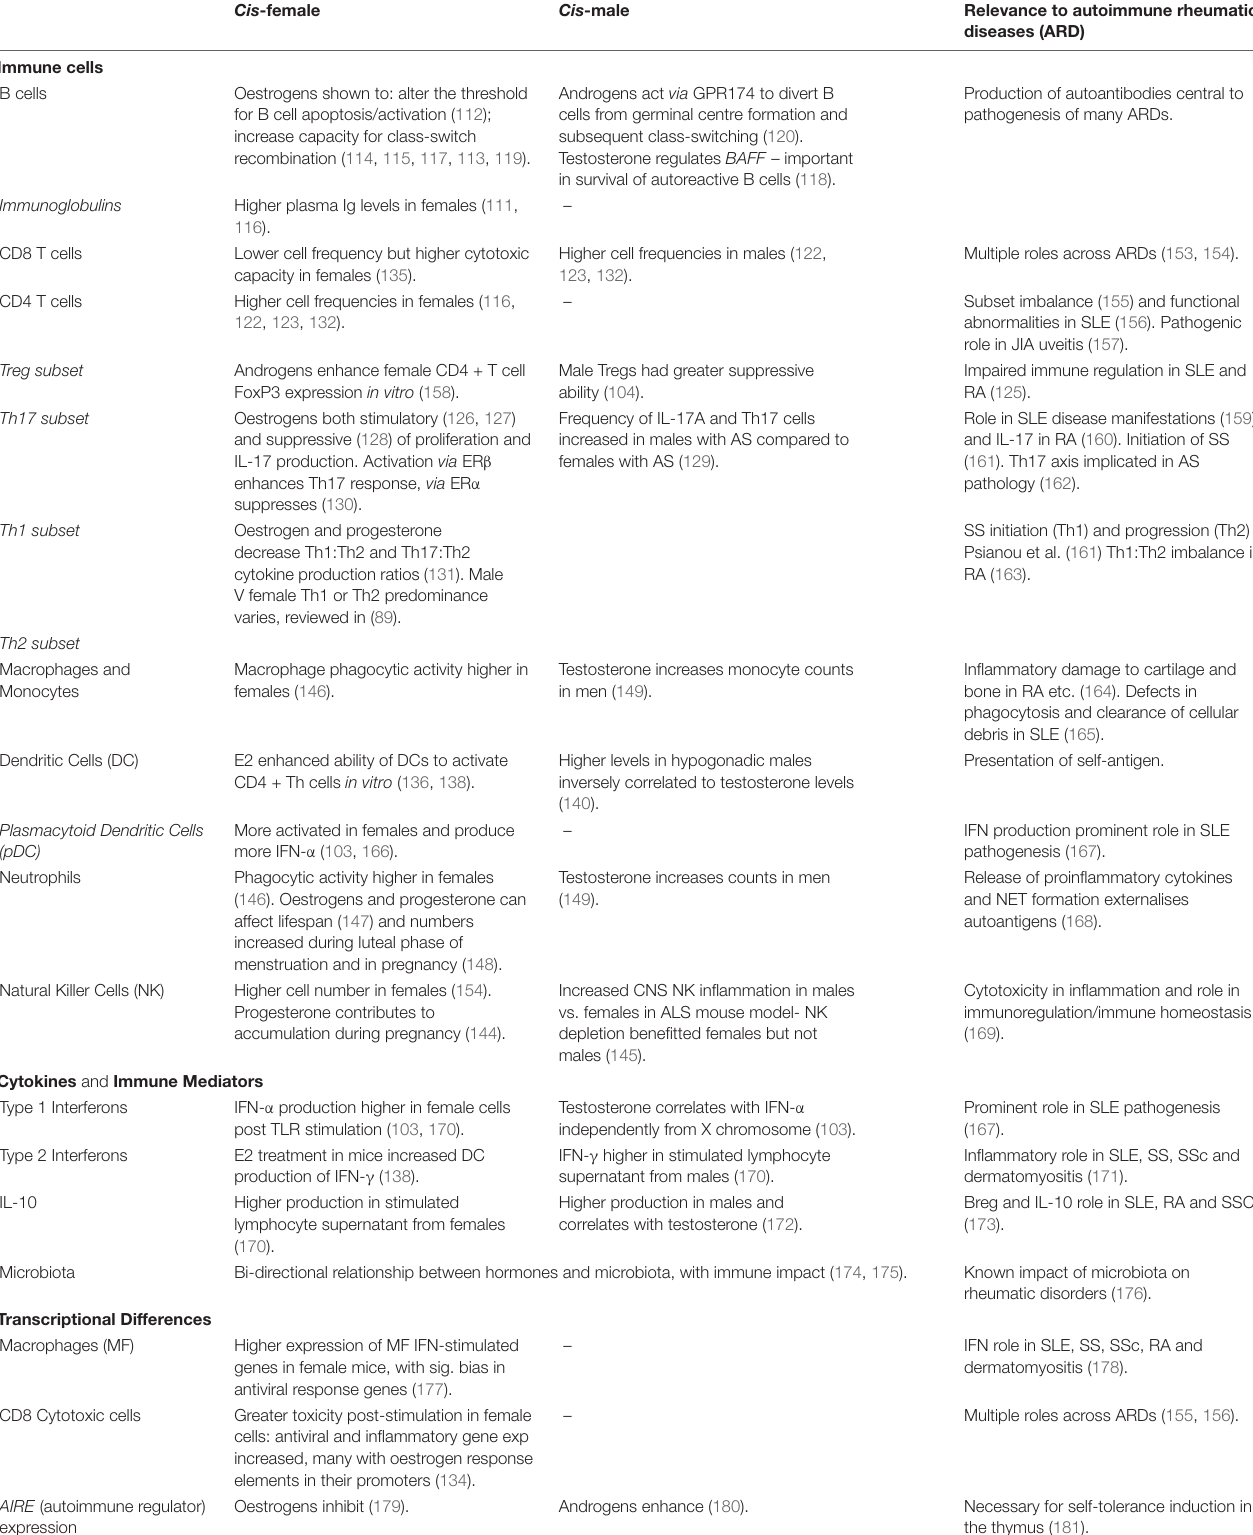
TABLE 1 | Summary of notable immune system elements known to be regulated by sex determinants and their relevance to autoimmune rheumatic